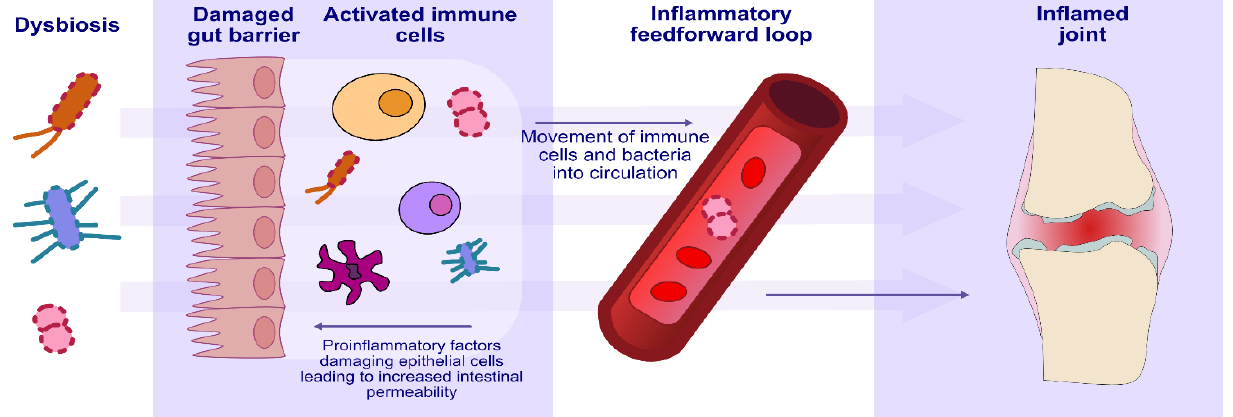
Figure 4. The involvement of oral microbiome dysbiosis in the development of rheumatoid arthritis. The oral microbiome plays a significant role not only in maintaining oral health but